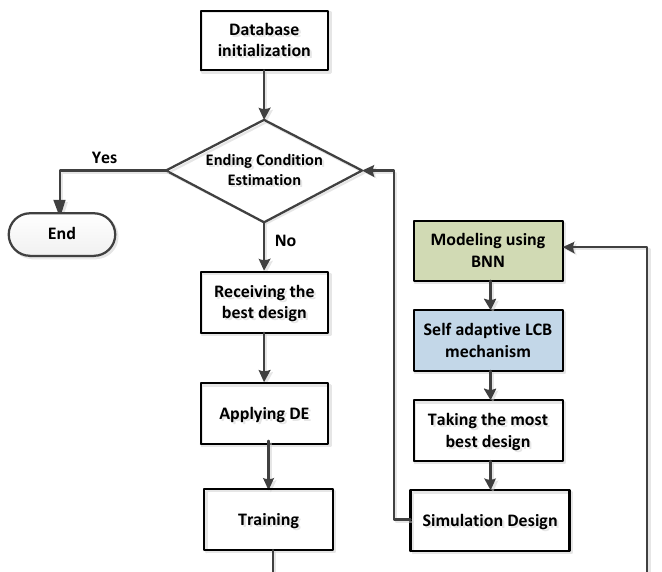
Figure 1. Flow chart description of presented SADE for antenna design optimization.